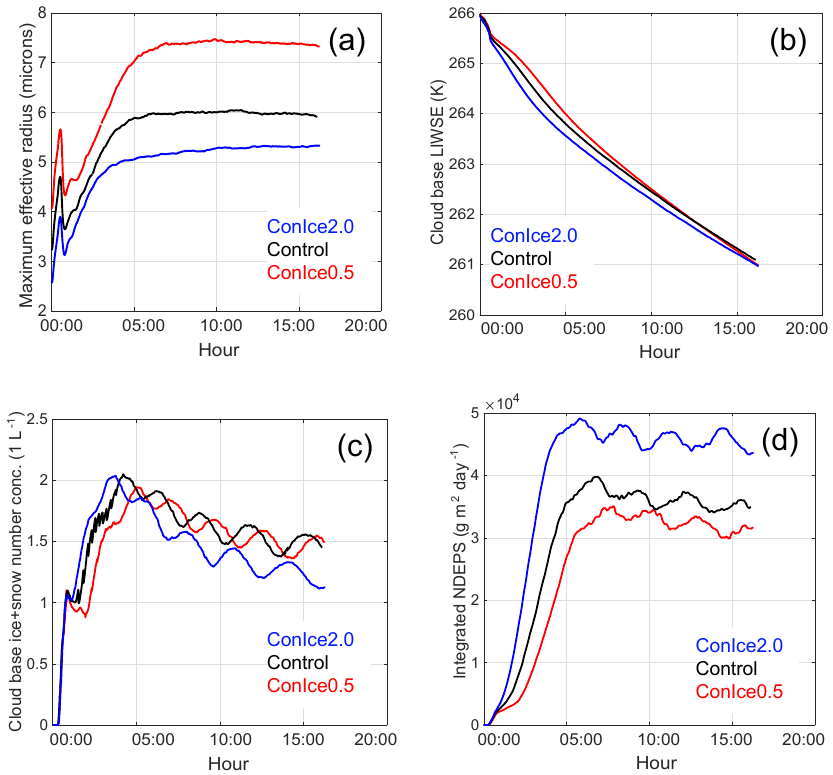
Figure 5. Time series from runs varying CCN concentrations with constant ice formation. (a) Maximum effective radius, in units of microns. (b) Cloud mixed-layer liquid–ice water static energy, in units of K. (c) Cloud base ice plus snow number concentration, in units of L − 1 . (d) Vertically integrated net deposition rate, in units of gm − 2 day − 1 . For INP factors equal to 1.0 and CCN factors 0.5 (red), 1.0 (black), and 2.0